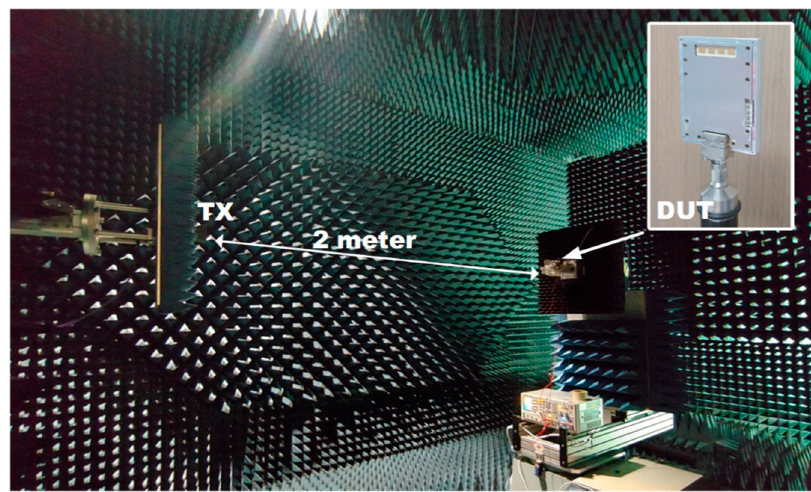
Figure 8. Anechoic chamber test setup for the radiation pattern over the air.